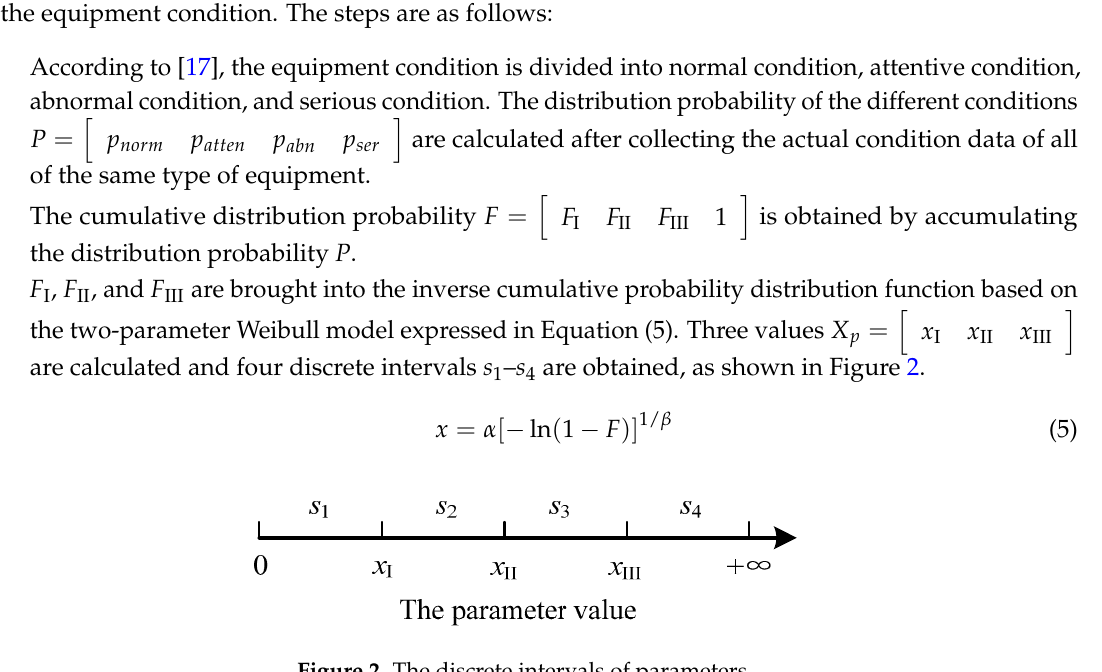
Figure 2. The discrete intervals of parameters.